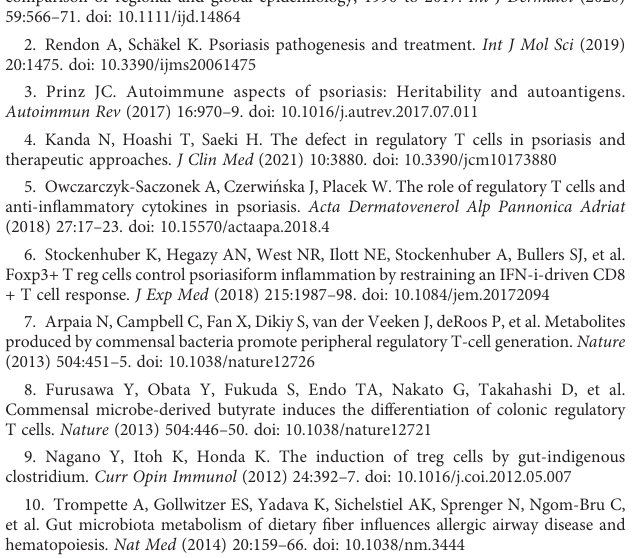
SUPPLEMENTARY FIGURE 1 Cells from LN and spleens obtained from 4 WT and 4 HCA2-KO mice were isolated separately and subjected to FACS analysis. Cells were gated for Foxp3 and double positive cells (Foxp3/CD25) were analyzed. The number of double positive cells is displayed in the histograms. FACS analysis is also shown as